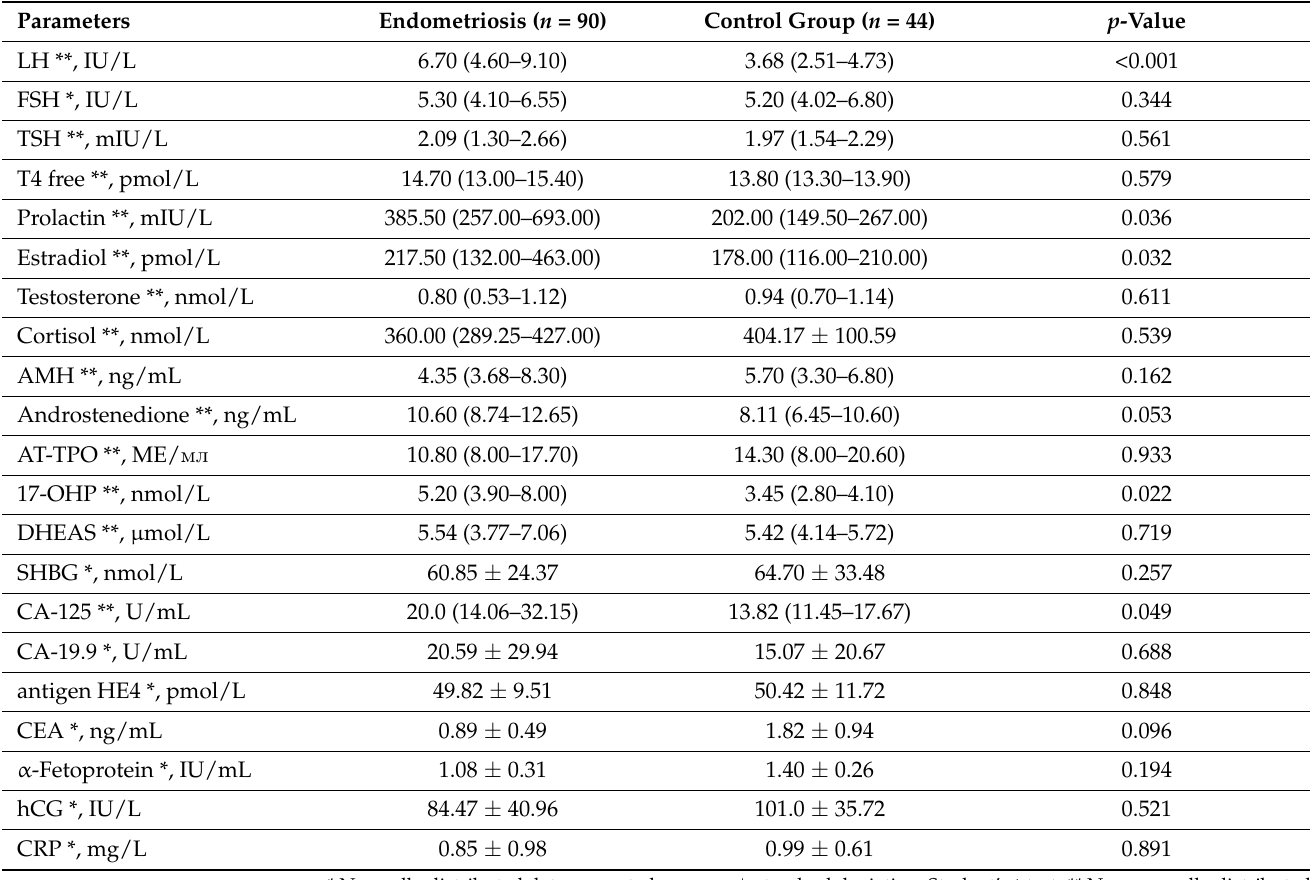
Table 2. Plasma levels of hormones and tumor markers in adolescents with endometriosis and “healthy” girls.